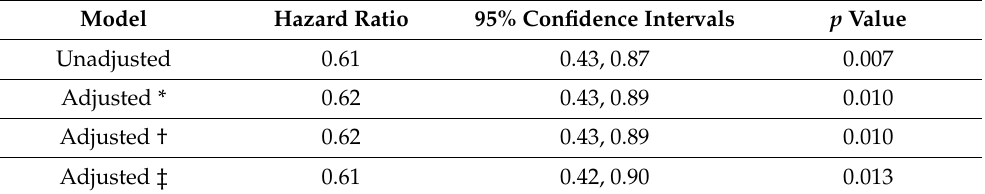
Table 2. Association of anticoagulant prescription with AAA-related events.